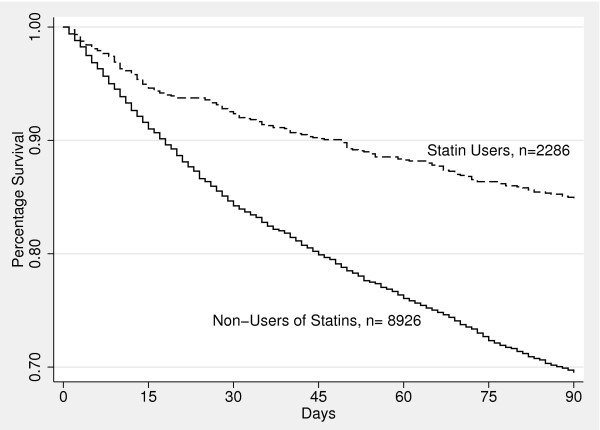
Proportion of surviving patients hospitalized with COPD exacerbation by use of statin versus non-use (p < 0.0001).